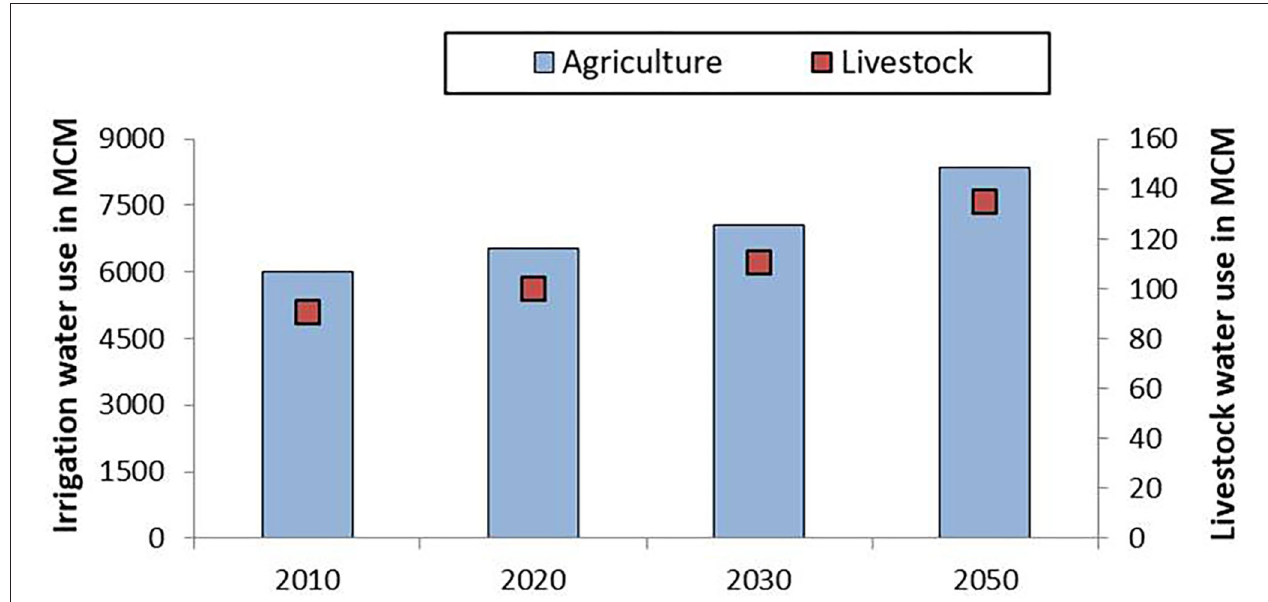
FIGURE 7 | Water demand estimates for irrigation and livestock sectors in the study area. Source: Authors’ own